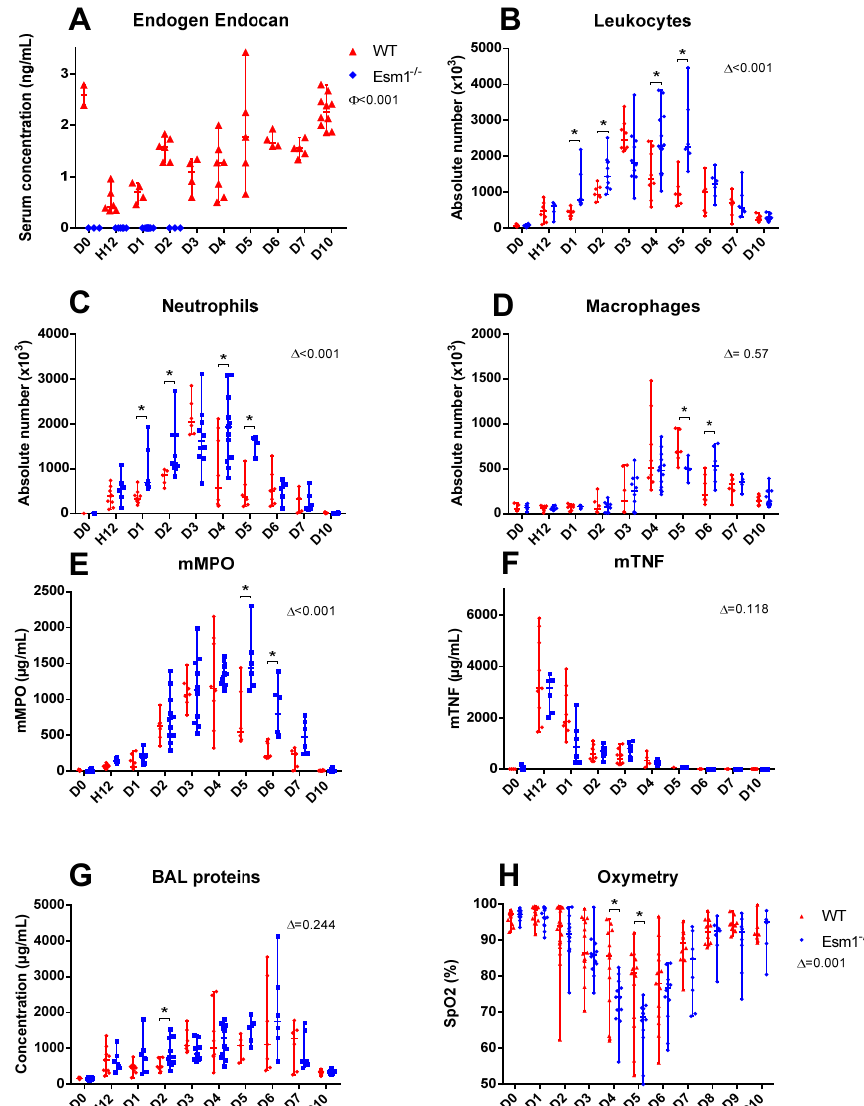
Figure 2. Endogenous endocan alleviates the inflammatory response and improves pulmonary physiological function. The inflammatory response in WT (red) and Esm1 − / − (blue) mice after the intratracheal instillation of LPS at different time points. The evolution of endogenous endocan serum concentrations at different timings are shown in ( A ). The BAL examinations are shown, with the absolute number of leukocytes ( B ), neutrophils ( C ), and macrophages ( D ). mMPO BAL concentrations are shown in ( E ), mTNF BAL concentrations are shown in ( F ), and protein BAL concentrations are shown in ( G ). The evolution of transcutaneous oximetry at different timings is shown in ( H ). Data are represented by their median, 25th, and 75th percentiles. ∆ represents the estimation of the effect of the group according to the linear mixed model test. Φ is the result of the Kruskal–Wallis test. * represents a p < 0.05 as the result of the Mann–Whitney test between the variable of each group at a specific timing. H12: 12 h after tracheal instillation of LPS.